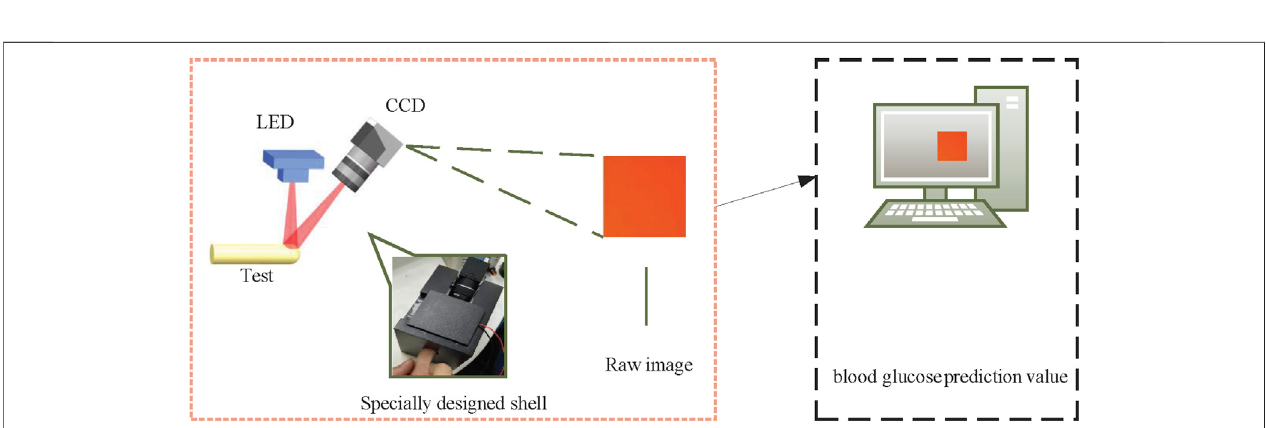
FIGURE 3 | Diagram of the system. A specially designed shell is used to fi x the LED, CCD and a position for the test.